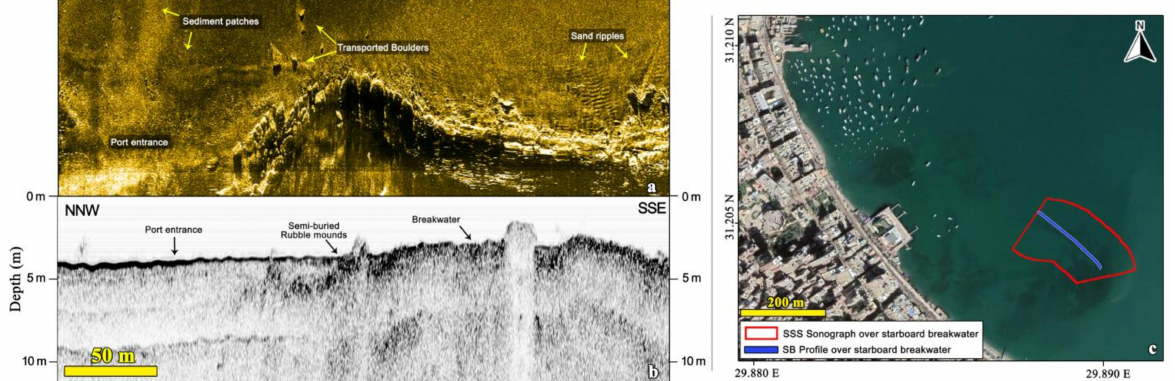
Figure 10. The starboard side breakwater of the submerged ancient harbor. ( a ) Side scan sonar image; ( b ) Sub-bottom profiler section; ( c ) Location map of the displayed images.